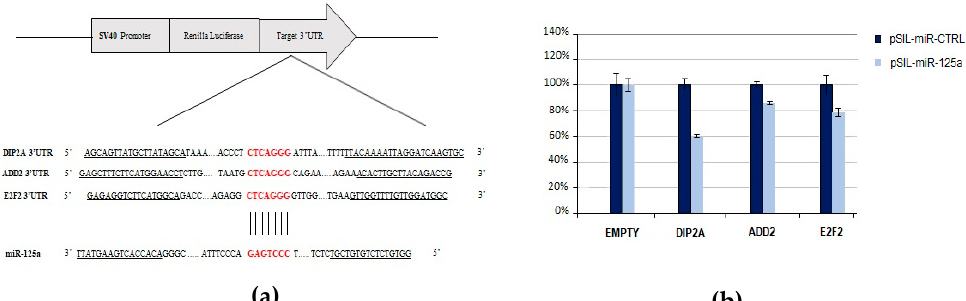
Figure 6. Experimental validation of miR-125a-5p and its predicted target genes by using luciferase reporter constructs. ( a ) Schematic representation of the psiCHECK2 luciferase reporter constructs containing the 3’UTR fragments of target genes cloned downstream the Renilla Luciferase gene. The sequence alignment between miR-125a seed region and target genes is reported. ( b ) The HEK-293T cells were co-transfected with four different experimental designs: (1) psiCHECK2-empty and pSIL-miR-CTRL; (2) psiCHECK2-empty and pSIL-miR-125a; (3) psiCHECK2-3’UTR and pSIL-miR-CTRL; and (4) psiCHECK2-3’UTR and pSIL-miR-125a. Y-axis represents Renilla Luciferase activity (%) normalized to Firefly Luciferase activity. Data represent the averages of at least three independent experiments with their standard deviations. The p -value was calculated by t -test. * p -value < 0.05.